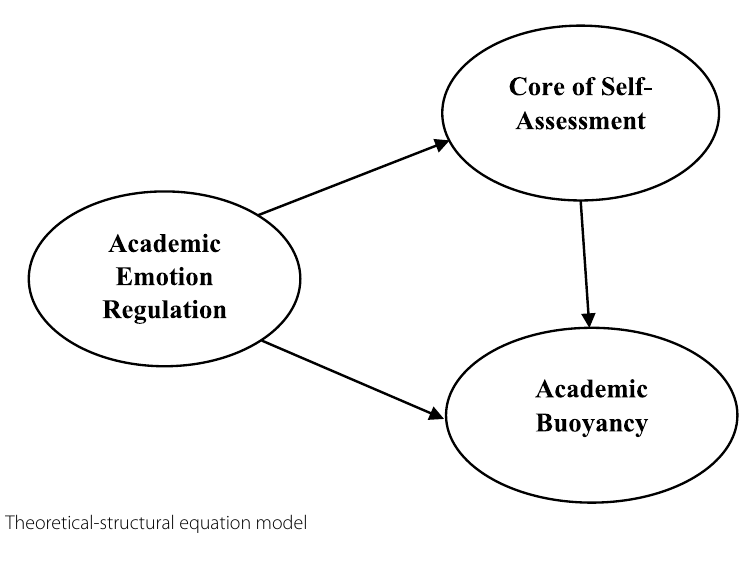
Fig. 1 Theoretical‑structural equation